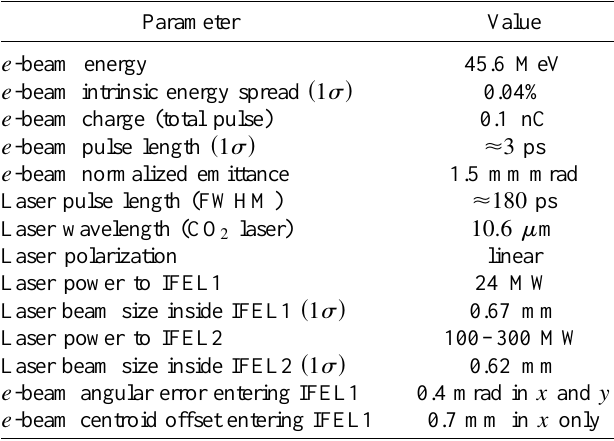
TABLE I. STELLA experimental parameters and values used in the model. Parameter